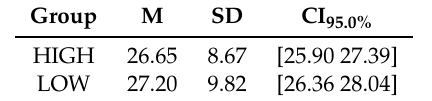
Table A5. Channels’ counts: EO HIGH and LOW stress-susceptible groups. Mean (M), standard deviation (SD), median (Mdn), and 95.0% confidence interval (CI 95.0% ) associated with